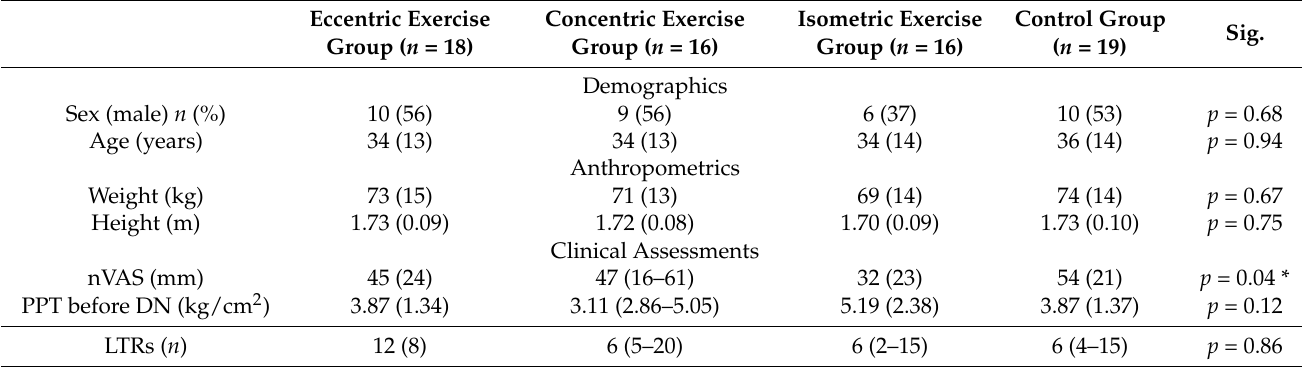
Table 1. Baseline characteristics of